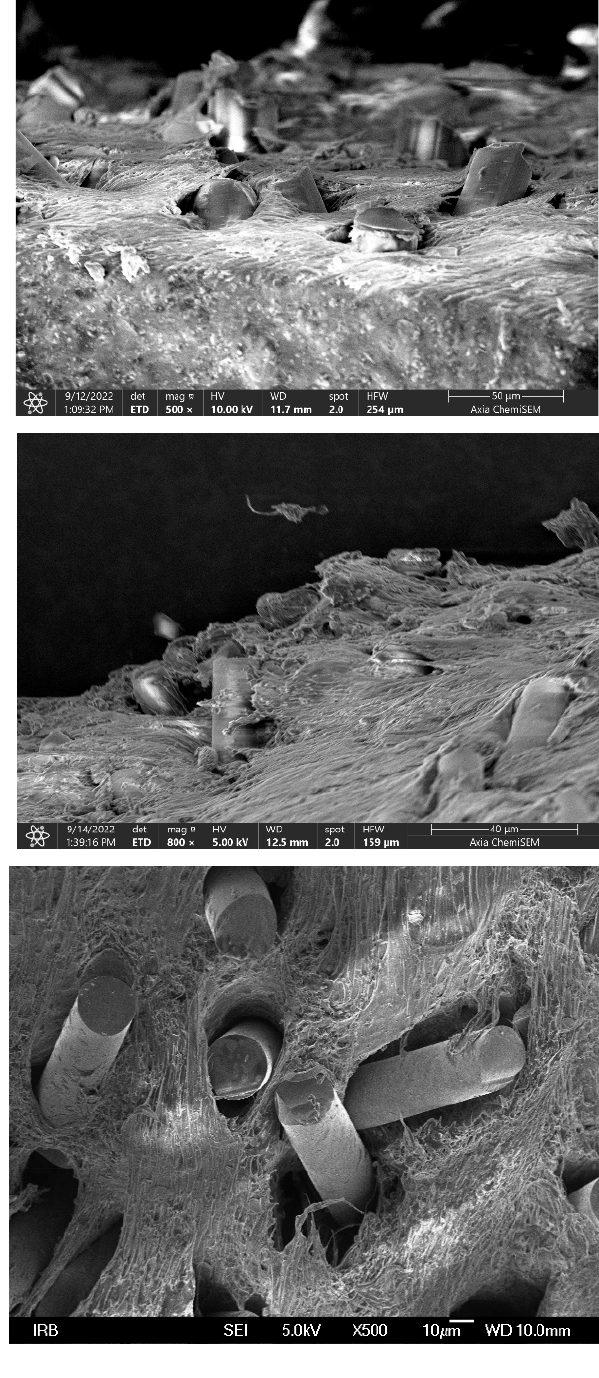
Figure 3. SEM images of surface ( left-hand side ) and cross-section ( right-hand side ) of ( a ) neat PLA, ( b ) PLA–WG, ( c ) PLA–IPG, ( d ) PLA–HYBG, and ( e ) PLA–ARG composites.